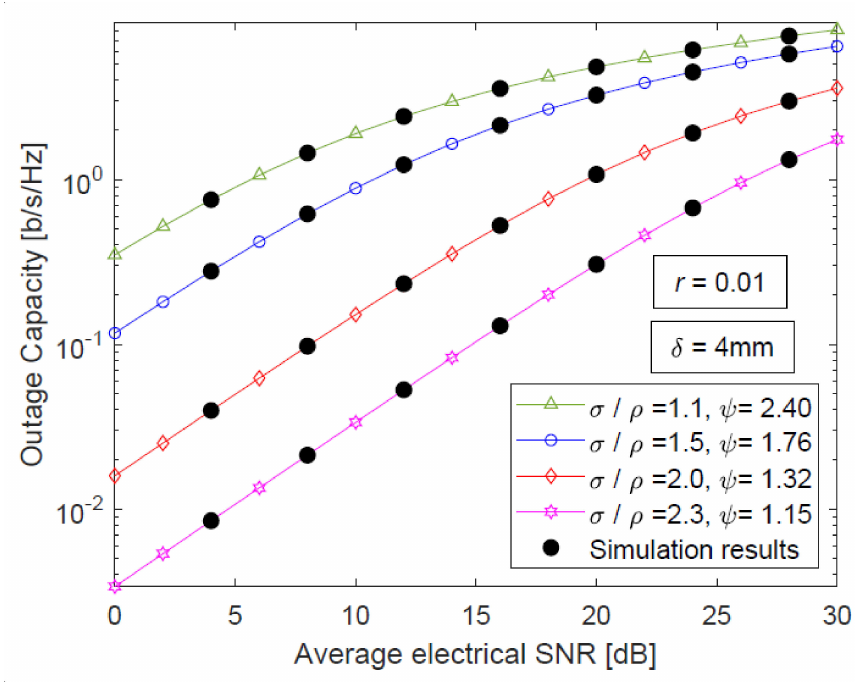
Figure 3. Outage capacity versus average electrical SNR for δ = 4 mm and r = 0.01 under the presence of varying, weak to strong stochastic pointing